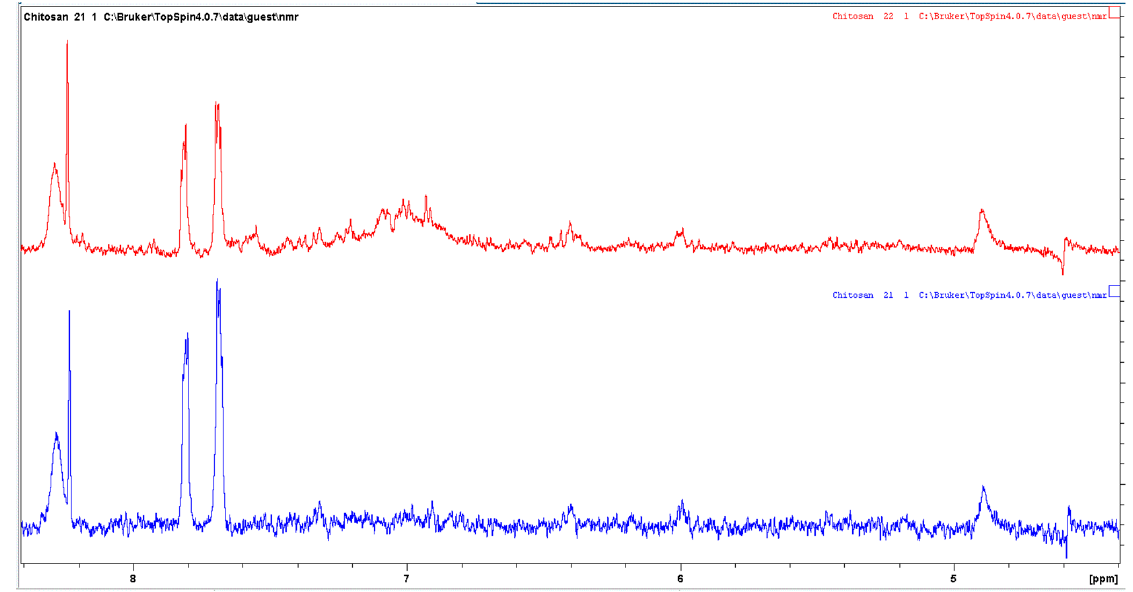
Figure 9. Enhanced solution phase 1 H NMR spectra of chitosan (blue) and enzymatically modified chitosan (red). Both samples had the same chitosan concentration (~1.5 mg/mL).